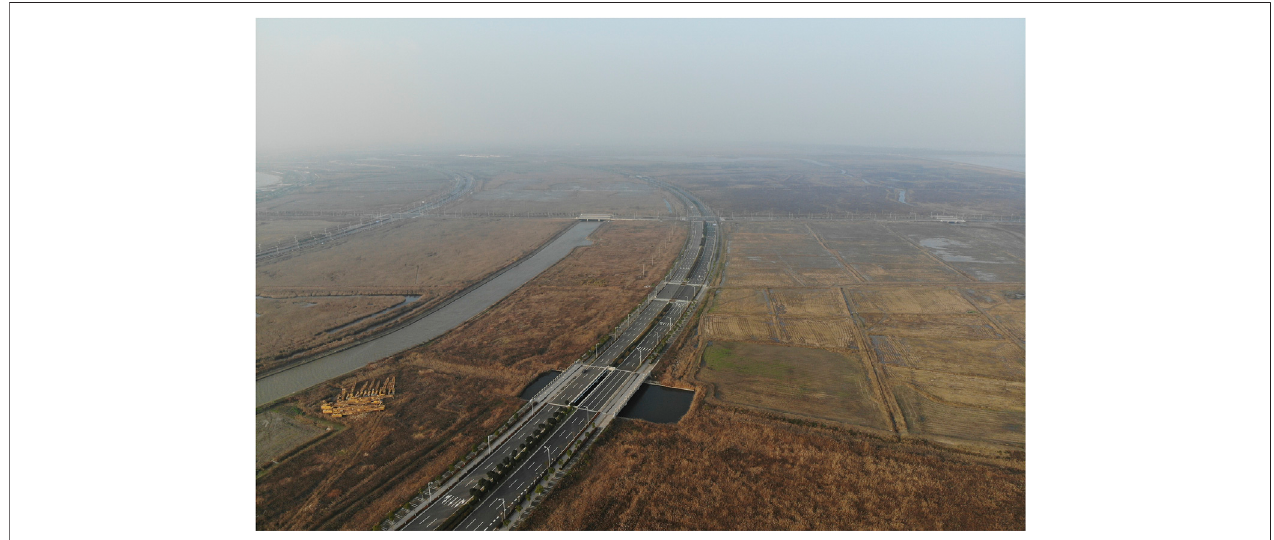
FIGURE 9 | Wetlands partly used for farming at Nanhui in the Pudong District. Lingang New Harbor City was planned here (Photo by author, December